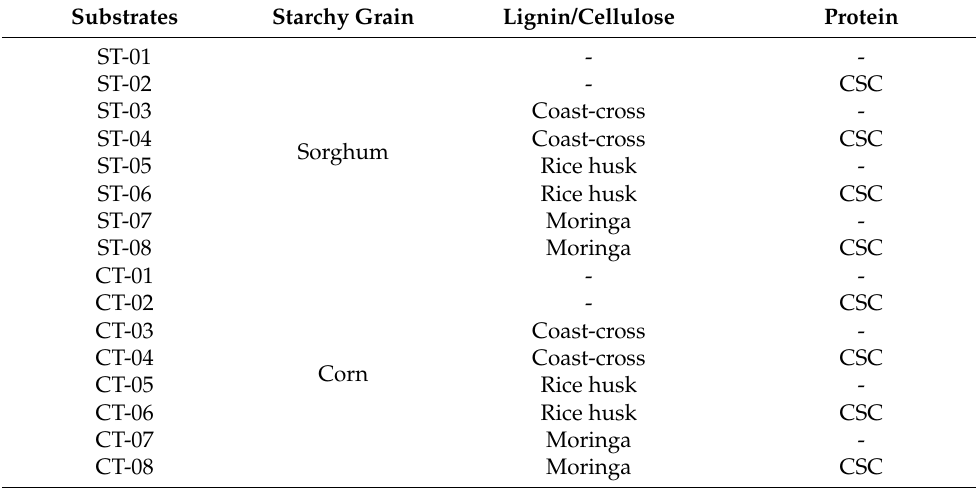
Table 2. Plant biomass substrates used as animal feed sources of starch (sorghum, corn, and oat grains), lignin/cellulose (coast-cross, rice husk, and moringa) and protein (cottonseed cake, pigeon pea) that were tested for filamentous fungi